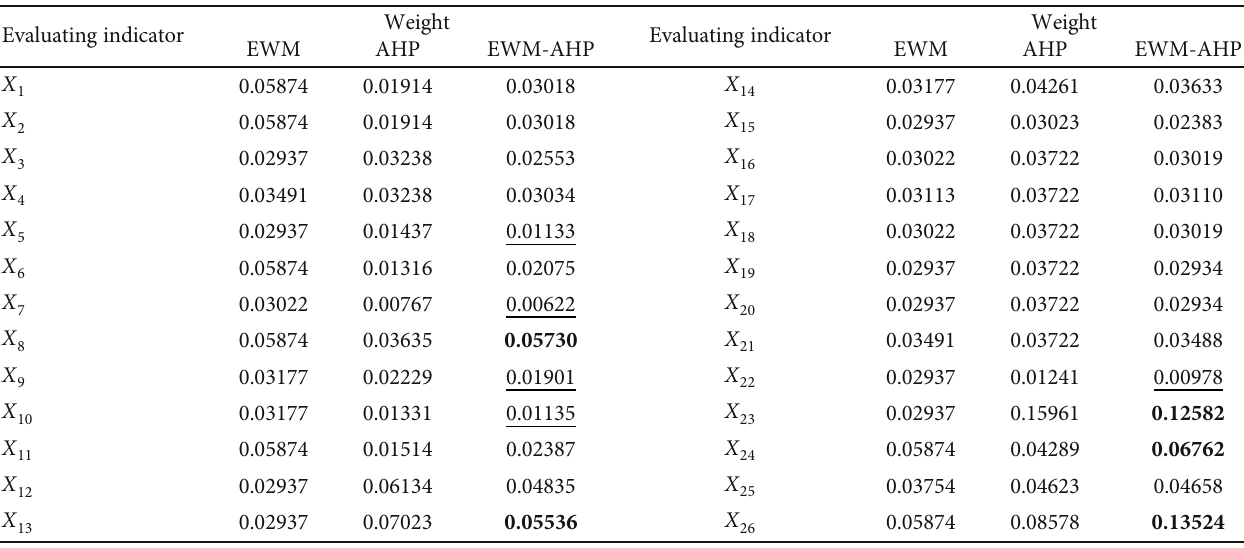
Table 9: Weights of evaluating indicators for Yirui limestone mine. The underlined values indicate the smallest fi ve evaluating indicator weights with the EWM-AHP method. The bold values indicate the largest fi ve evaluating indicator weights with the EWM-AHP method. Evaluating